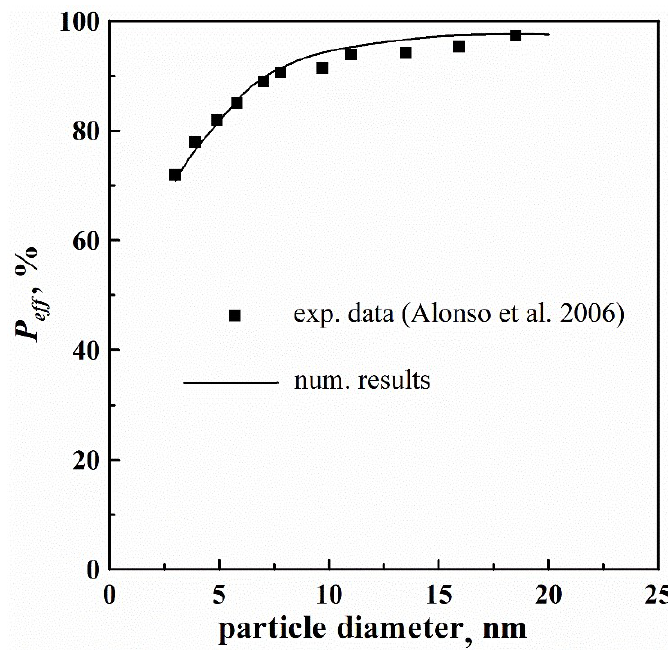
Figure 8. Comparison of numerical penetration efficiency of the hollow tapered cylinder with experimental data [24].